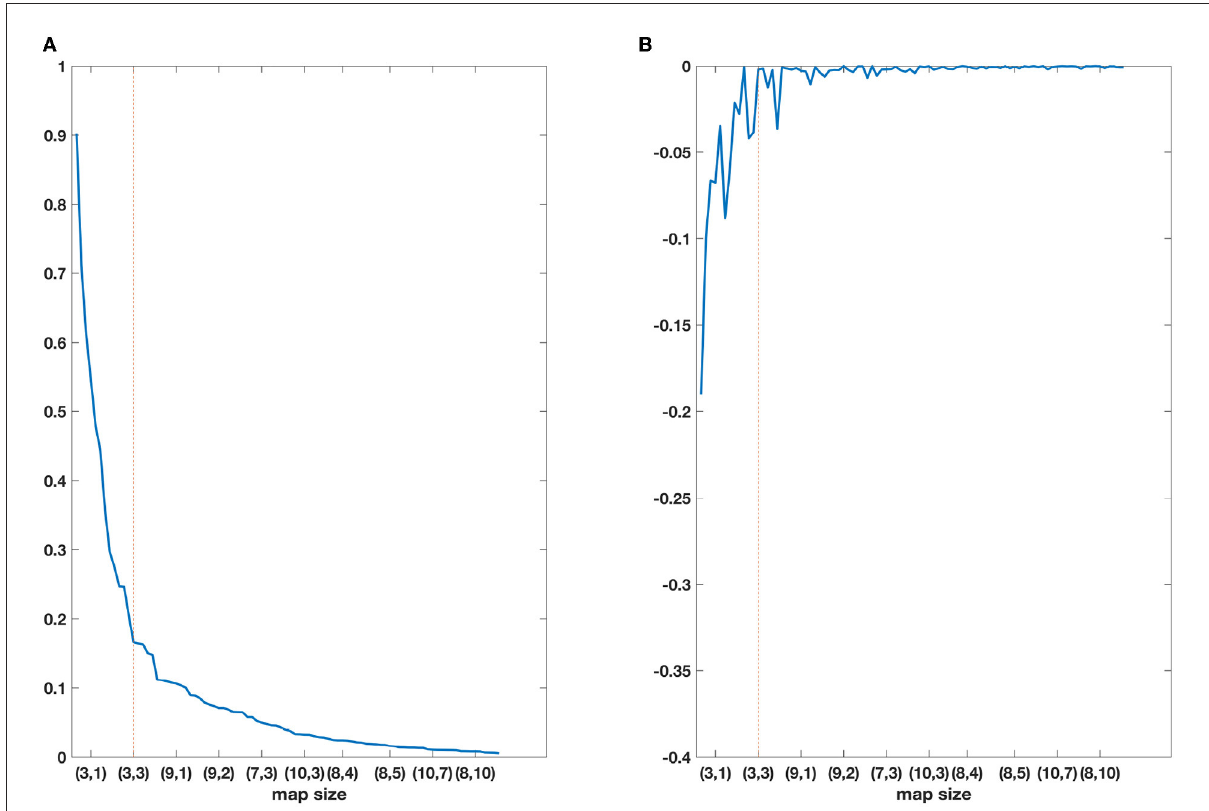
FIGURE3 (A) WSS/TSS varying with map size and (B) corresponding first difference. The determined map size is indicated by dashed